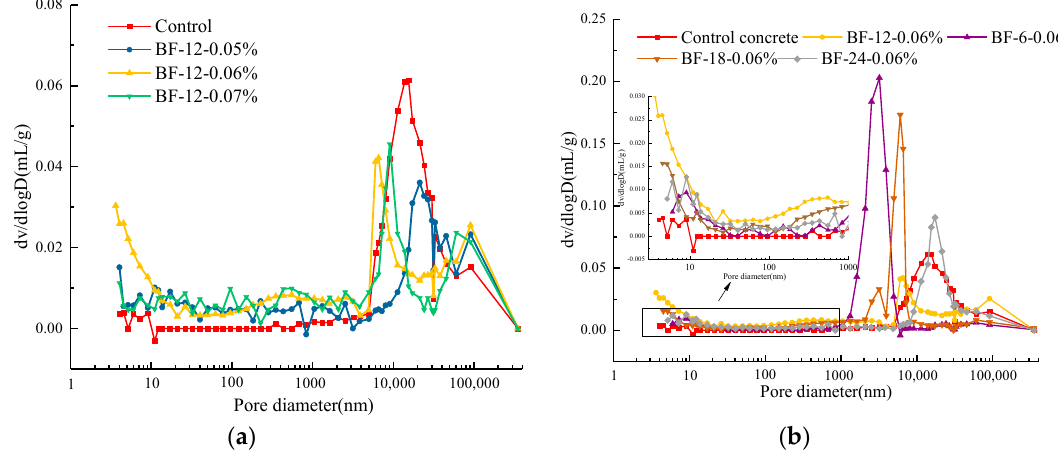
Figure 5. Pore size distribution of BFRCs with different ( a ) BF content ( b ) BF length.